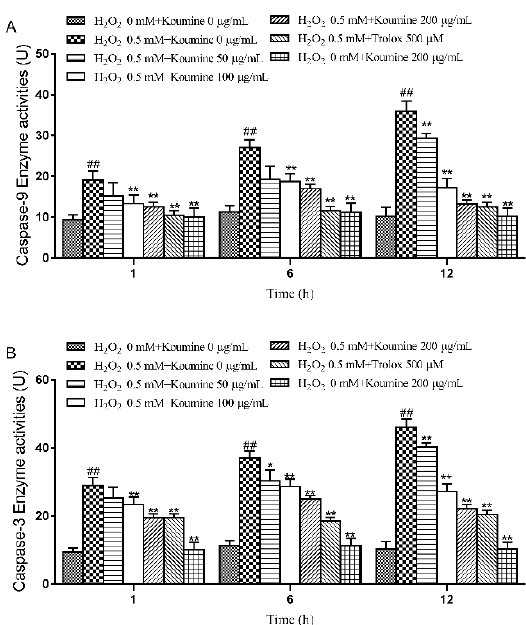
Figure 8. Effects of koumine on caspase activities in H 2 O 2 -induced IPEC-J2 cells. Cells were pretreated with 50–200 µ g/mL koumine or 500 µ M Trolox for 12 h, and then treated with 0.5 µ M H 2 O 2 for 1, 6 and 12 h in the preincubation mediums. Caspase activities were measured by caspase-3 and -9 activity assay kits. The data were expressed as mean ± SD ( n = 3). ## p < 0.01 vs. control group; * p < 0.05 and ** p < 0.01 vs. H 2 O 2 group. ( A ) The enzyme activities of caspase-9; ( B ) The enzyme activities of caspase-3.